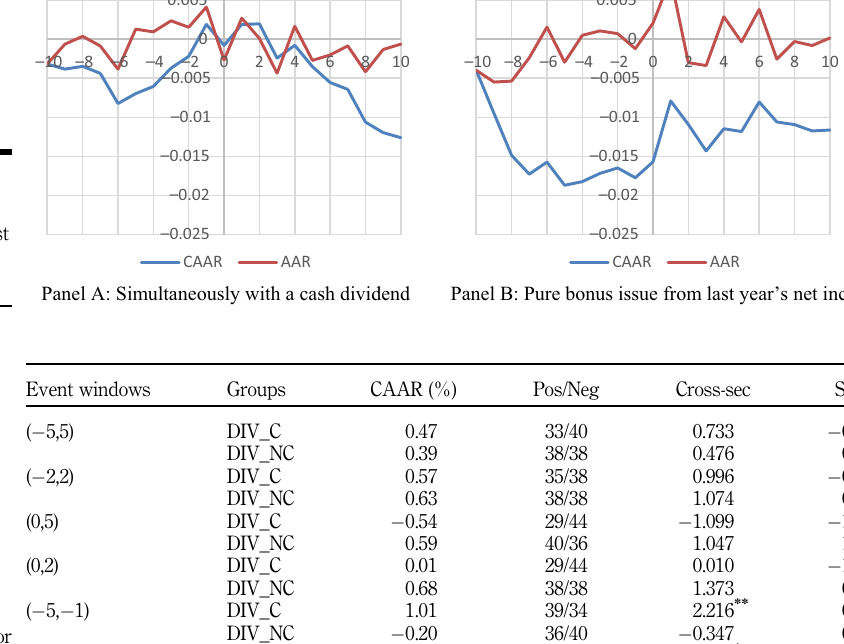
Table 4. Event study results for last year ’ s net income